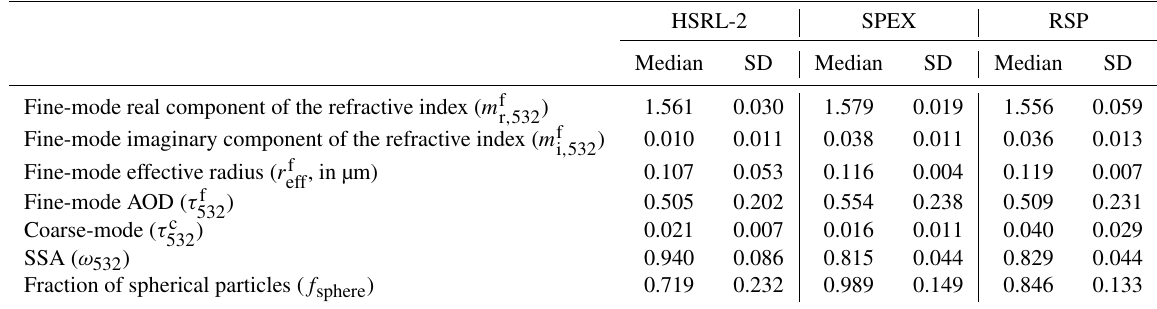
Table 7. Results of the HSRL-2 smoke-plume retrievals, along with the retrieved values from SPEX and RSP from Fu et al. (2020) for comparison. HSRL-2 SPEX RSP Median SD Median SD Median SD Fine-mode real component of the refractive index ( m f ) 1.561 0.030 1.579 0.019 1.556 0.059 r , 532 Fine-mode imaginary component of the refractive index ( m f ) 0.010 0.011 0.038 0.011 0.036 0.013 i , 532 Fine-mode effective radius ( r f , in µm) 0.107 eff Fine-mode AOD ( τ f ) 532 Coarse-mode ( τ c ) 532 SSA ( ω 532 ) 0.940 Fraction of spherical particles ( f sphere ) 0.719